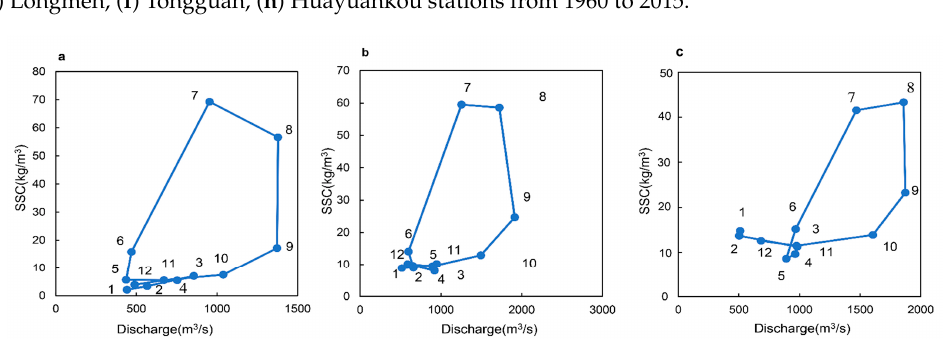
Figure 4. Monthly average hysteresis loop of SSC and discharge during the period of ( a ) 1960 − 1968, ( b ) 1969 − 1986, ( c ) 1987 − 2015 at Toudaoguai station.